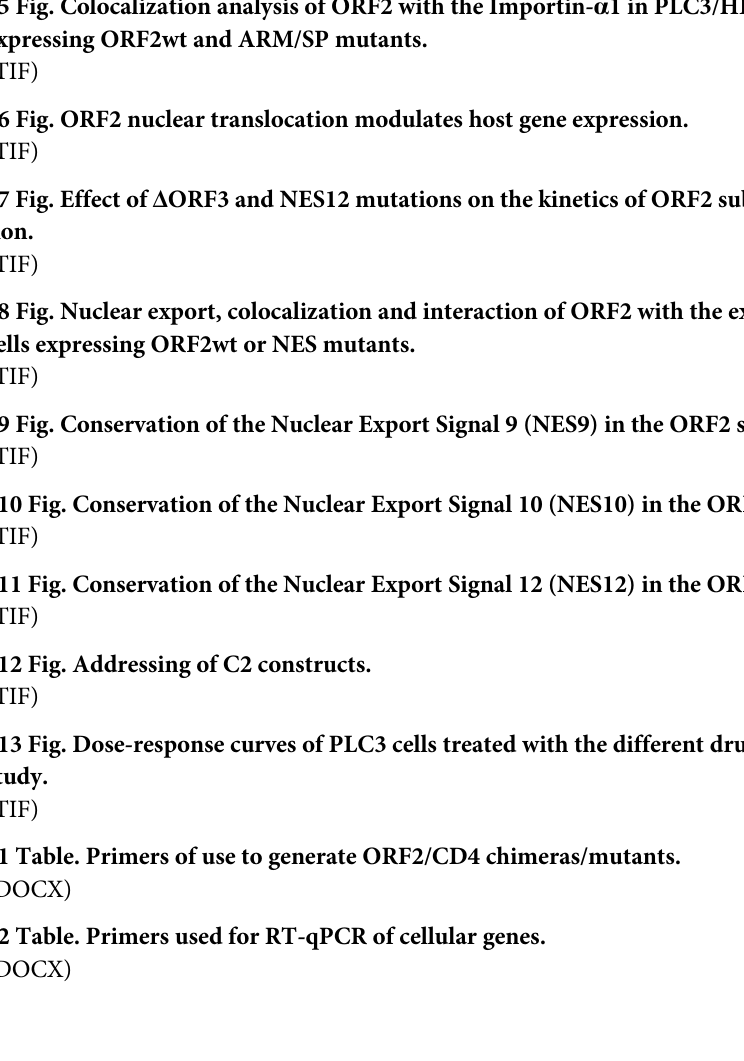
S1 Fig. Conservation of the Arginine-Rich Motif (ARM) in the ORF2 sequence. S2 Fig. Effect of 5R/5A, PSG/3R and Δ SP mutations on the kinetics of ORF2 subcellular localization. S3 Fig. Colocalization analysis of ORF2 with the Golgi marker 130 (GM130) in PLC3/ HEV-p6 cells expressing ORF2wt or ARM/SP mutants. S4 Fig. Controls of RNA and infectious titers S5 Fig. Colocalization analysis of ORF2 with the Importin- α 1 in PLC3/HEV-p6 cells expressing ORF2wt and ARM/SP mutants. S6 Fig. ORF2 nuclear translocation modulates host gene expression. S7 Fig. Effect of Δ ORF3 and NES12 mutations on the kinetics of ORF2 subcellular localiza- tion. S8 Fig. Nuclear export, colocalization and interaction of ORF2 with the exportin CRM1 in cells expressing ORF2wt or NES mutants. S9 Fig. Conservation of the Nuclear Export Signal 9 (NES9) in the ORF2 sequence. S10 Fig. Conservation of the Nuclear Export Signal 10 (NES10) in the ORF2 sequence. S11 Fig. Conservation of the Nuclear Export Signal 12 (NES12) in the ORF2 sequence. S12 Fig. Addressing of C2 constructs. S13 Fig. Dose-response curves of PLC3 cells treated with the different drugs used in this study. S1 Table. Primers of use to generate ORF2/CD4 chimeras/mutants. S2 Table. Primers used for RT-qPCR of cellular